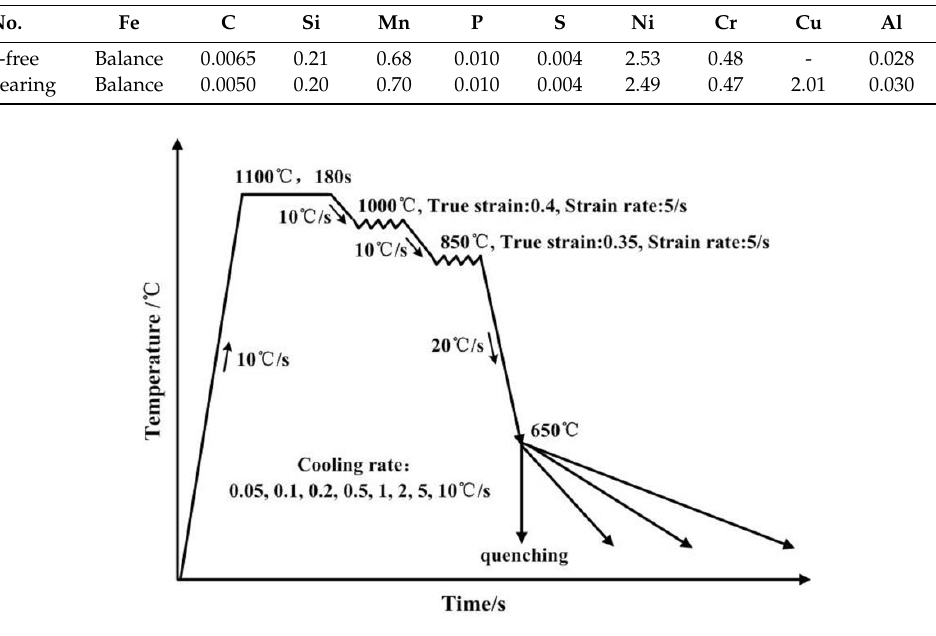
Figure 1. The schematic illustration of the thermal simulation experiments.